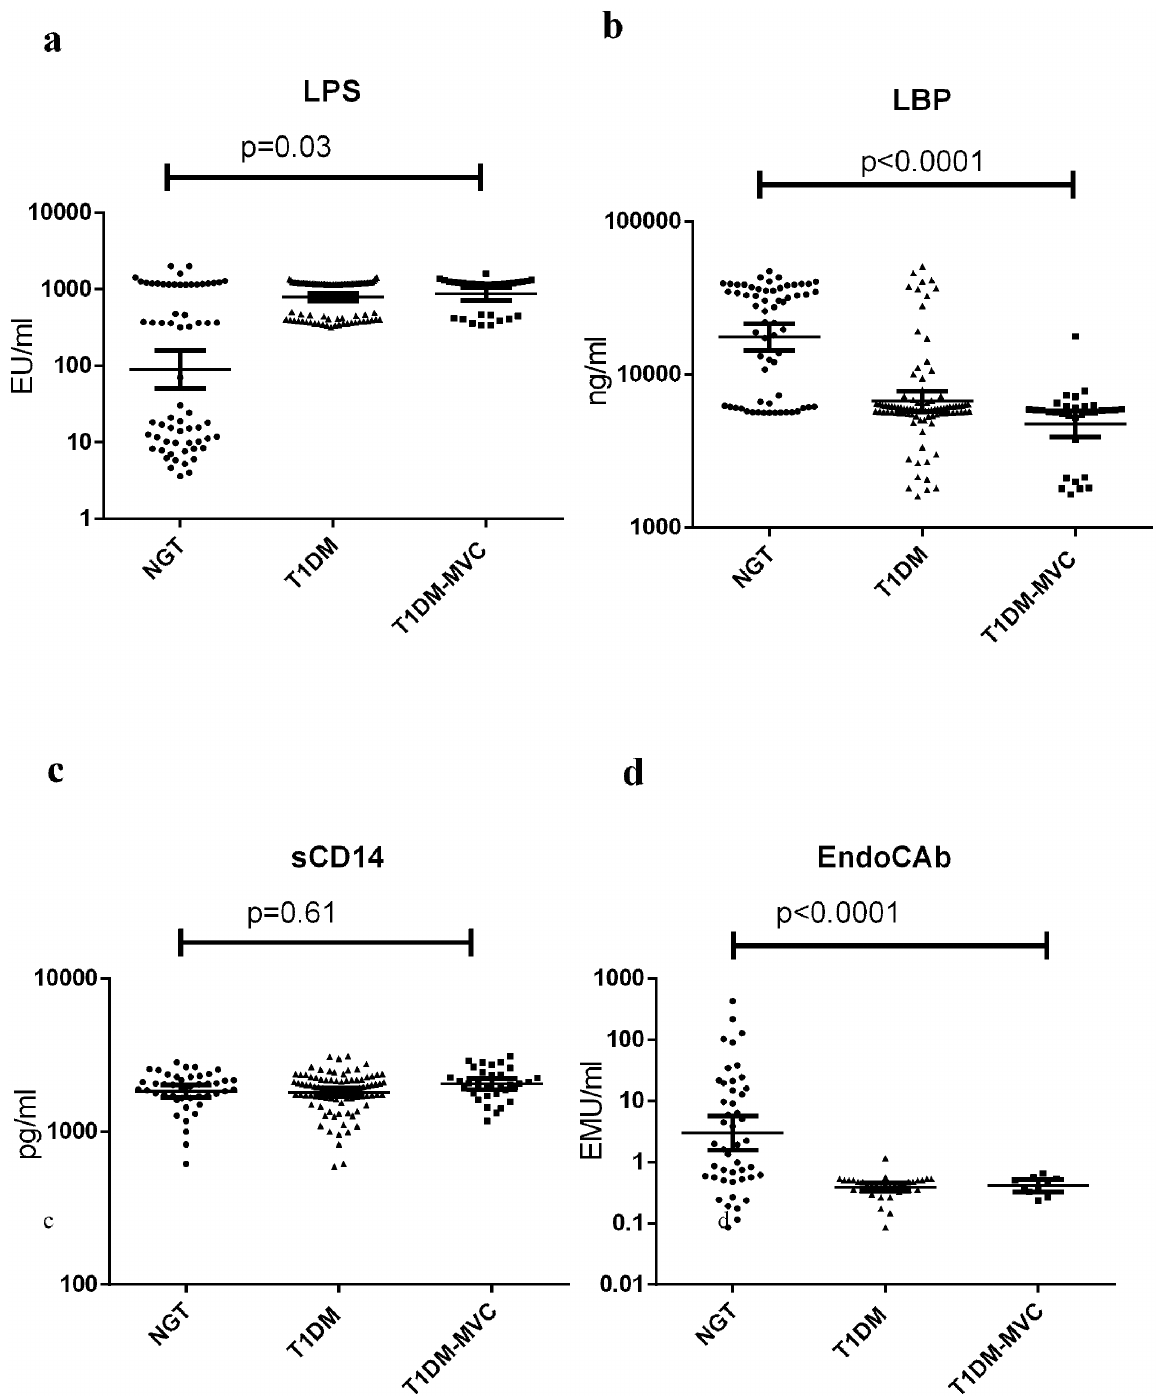
Fig 1. T1DM is characterized by systemic endotoxemia with significantly decreased levels of LBP and EndoCAb. Serum levels of LPS (a), LBP (b), sCD14 (c) and EndoCAb (d) were determined in NGT (n = 64), T1DM without MVC (n = 97) and T1DM subjects with MVC (n = 36) by immune-assays. Each dot represents individual values with the horizontal line representing the geo mean. 36 T1DM subjects without MVC and 26 with MVC had undetectable levels of EndoCAb. Significance was calculated by non-parametric Mann – Whitney U test and p < 0.05 was considered significant. The indicated p values are for pair-wise